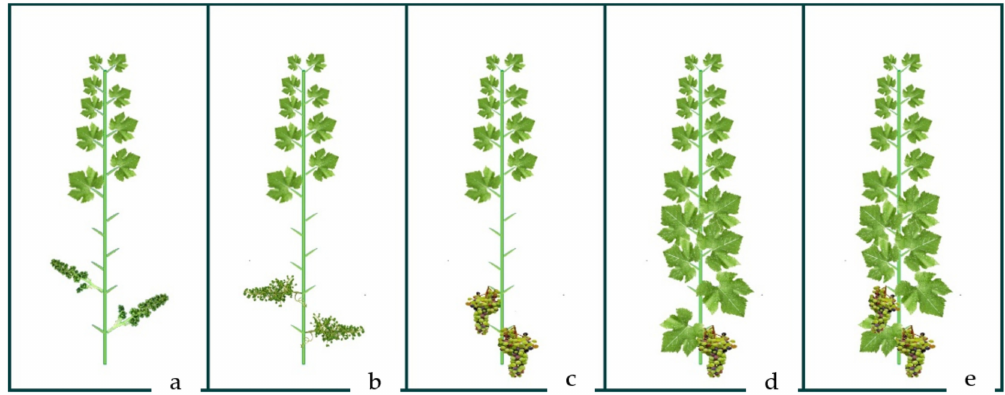
Figure 2. Visual illustration of canopy manipulation techniques of defoliation at preflowering ( a ), berry set ( b ), and veraison ( c ) and cluster thinning in veraison ( d ) in comparison to untreated control ( e